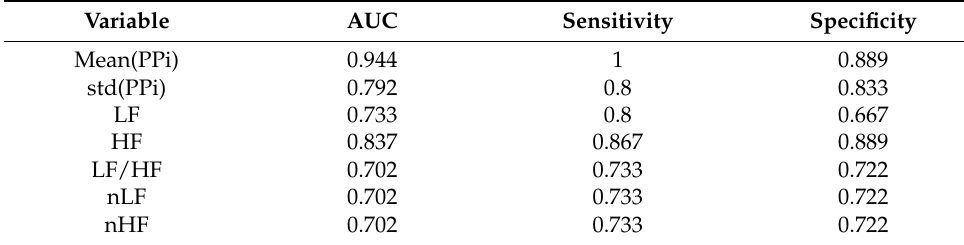
Table 5. The AUC of time and frequency domain indices of PRV.